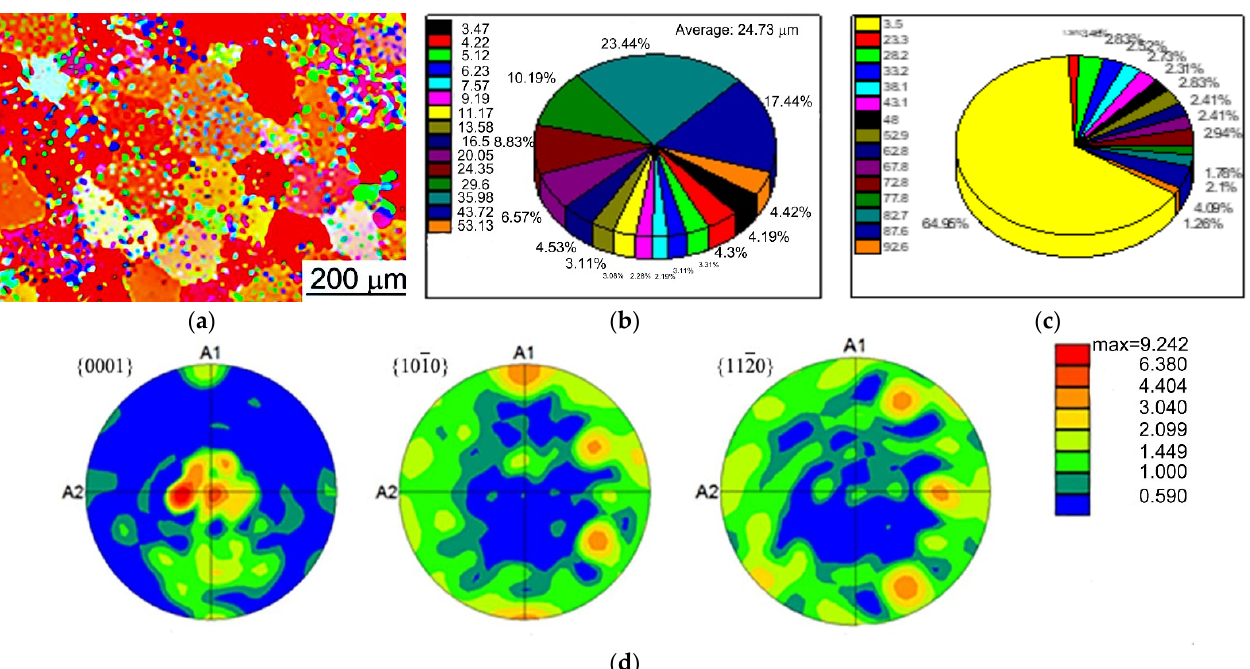
Figure 8. EBSD results of weld seam at flux coating amount of 1 mg/cm 2 . ( a ) Orientation image; ( b ) arain size; ( c ) misorientation angle; ( d ) pole figure.